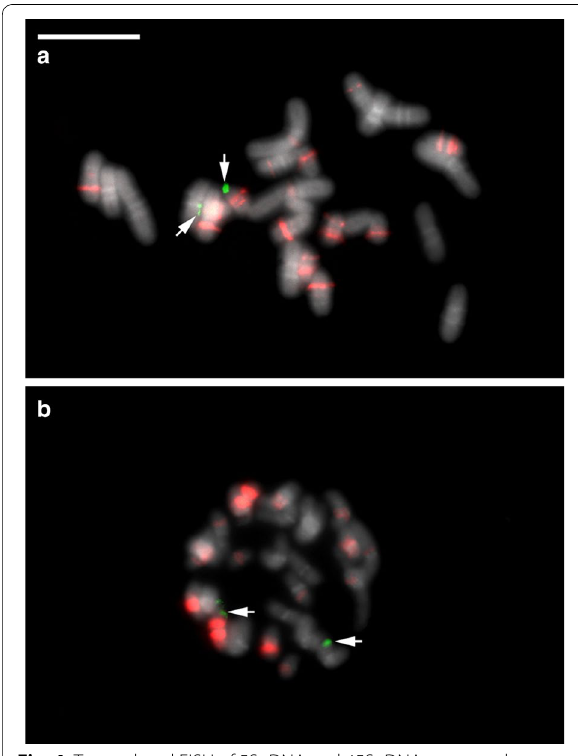
Fig. 4 Two‑colored FISH of 5S rDNA and 45S rDNA on metaphase chromosomes. a P. rungsuriyanum . b P. canhii . Chromosomes were counterstained with DAPI, and 45S rDNA ( green ) and 5S rDNA ( red ) sites were simultaneously detected in one reaction. In P. rungsuriya- num , 45S rDNA signals ( arrows ) and 5S rDNA signals were detected on the same chromosomes, while in P. canhii , 45S rDNA signals ( arrows ) and 5S rDNA signals were separated on different chromo‑ somes. Scale bar 10